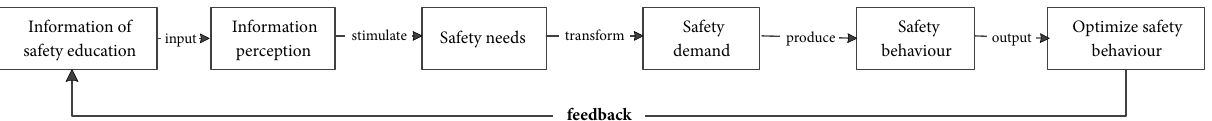
Figure 5. Process model for the information processing and utilization of IFSE centred on the